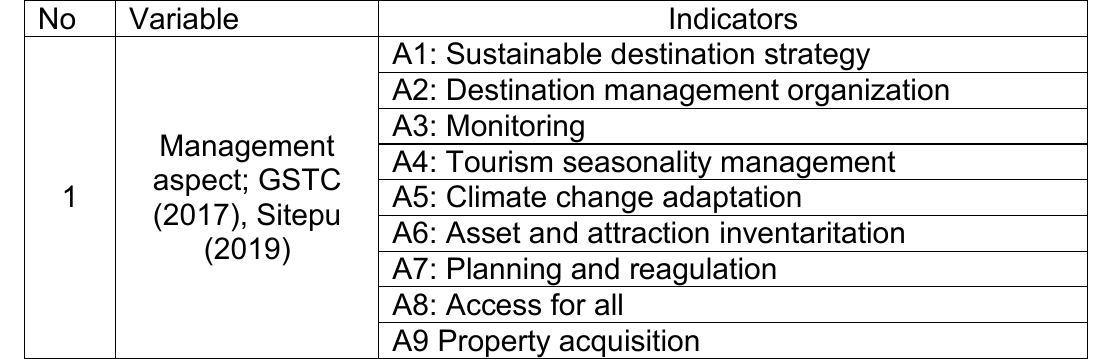
Table 1. Variable and Indicator Base on